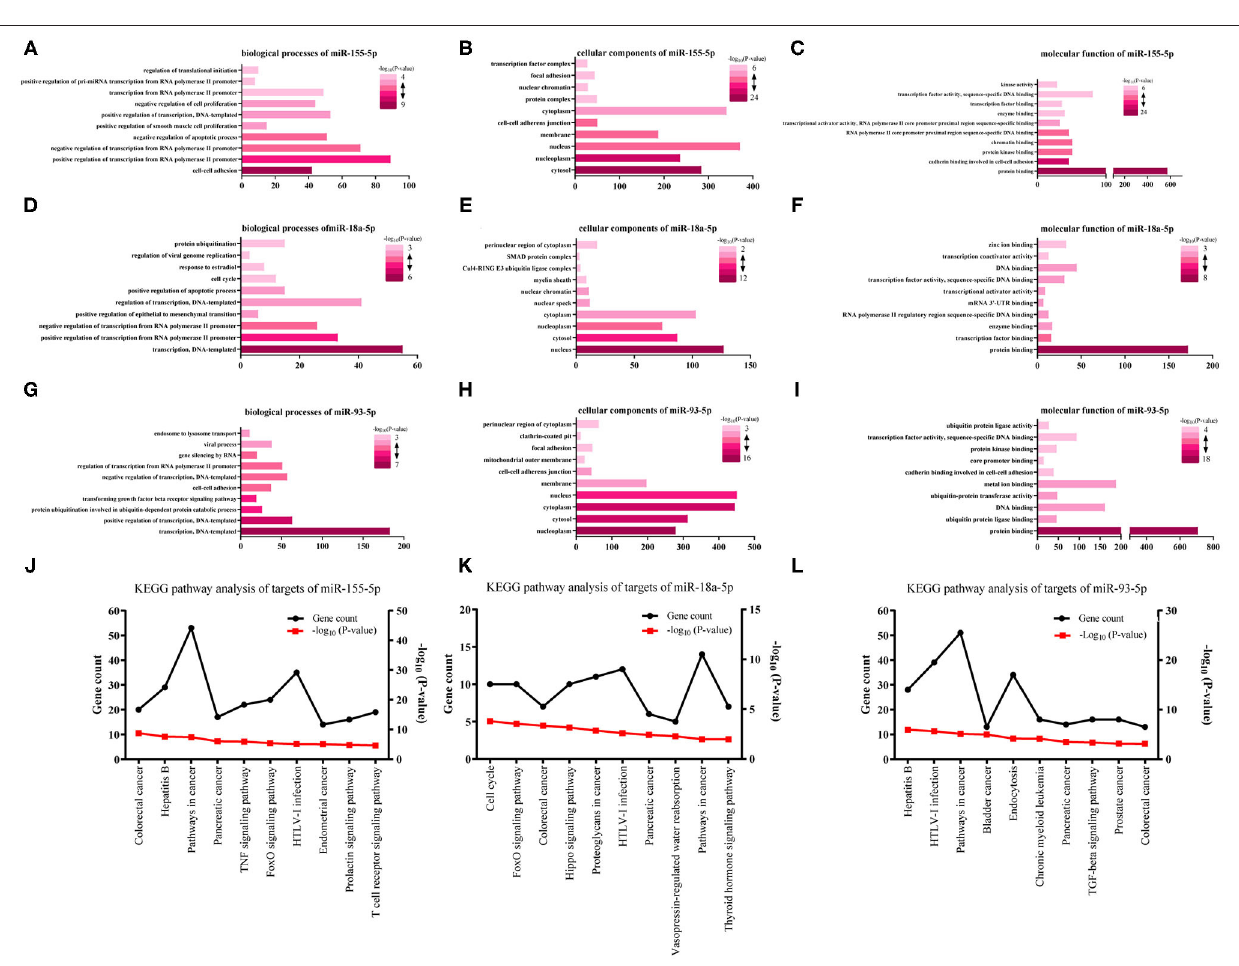
5% CO 2 in DMEM (Gibco BRL) to which 10% (v/v) FBS (Hyclone) served as a supplement, and we keep the temperature at 37 ◦